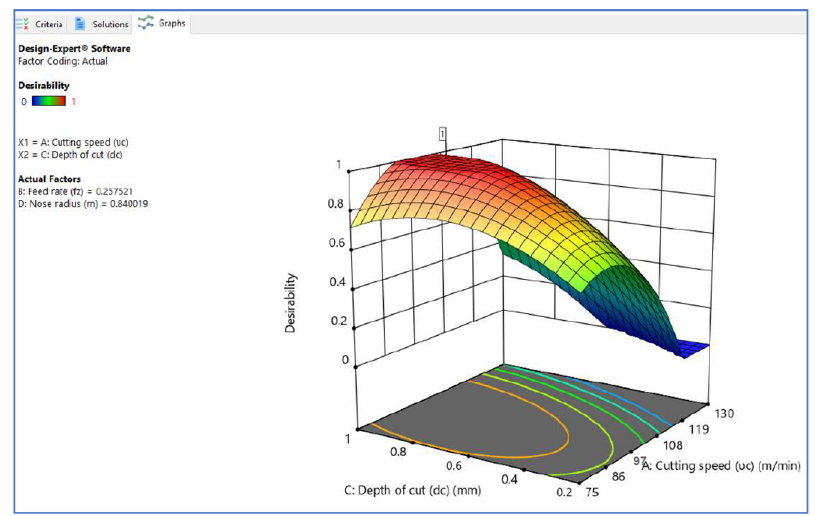
Figure 10. Surface plot on desirability (V c vs. D c ).